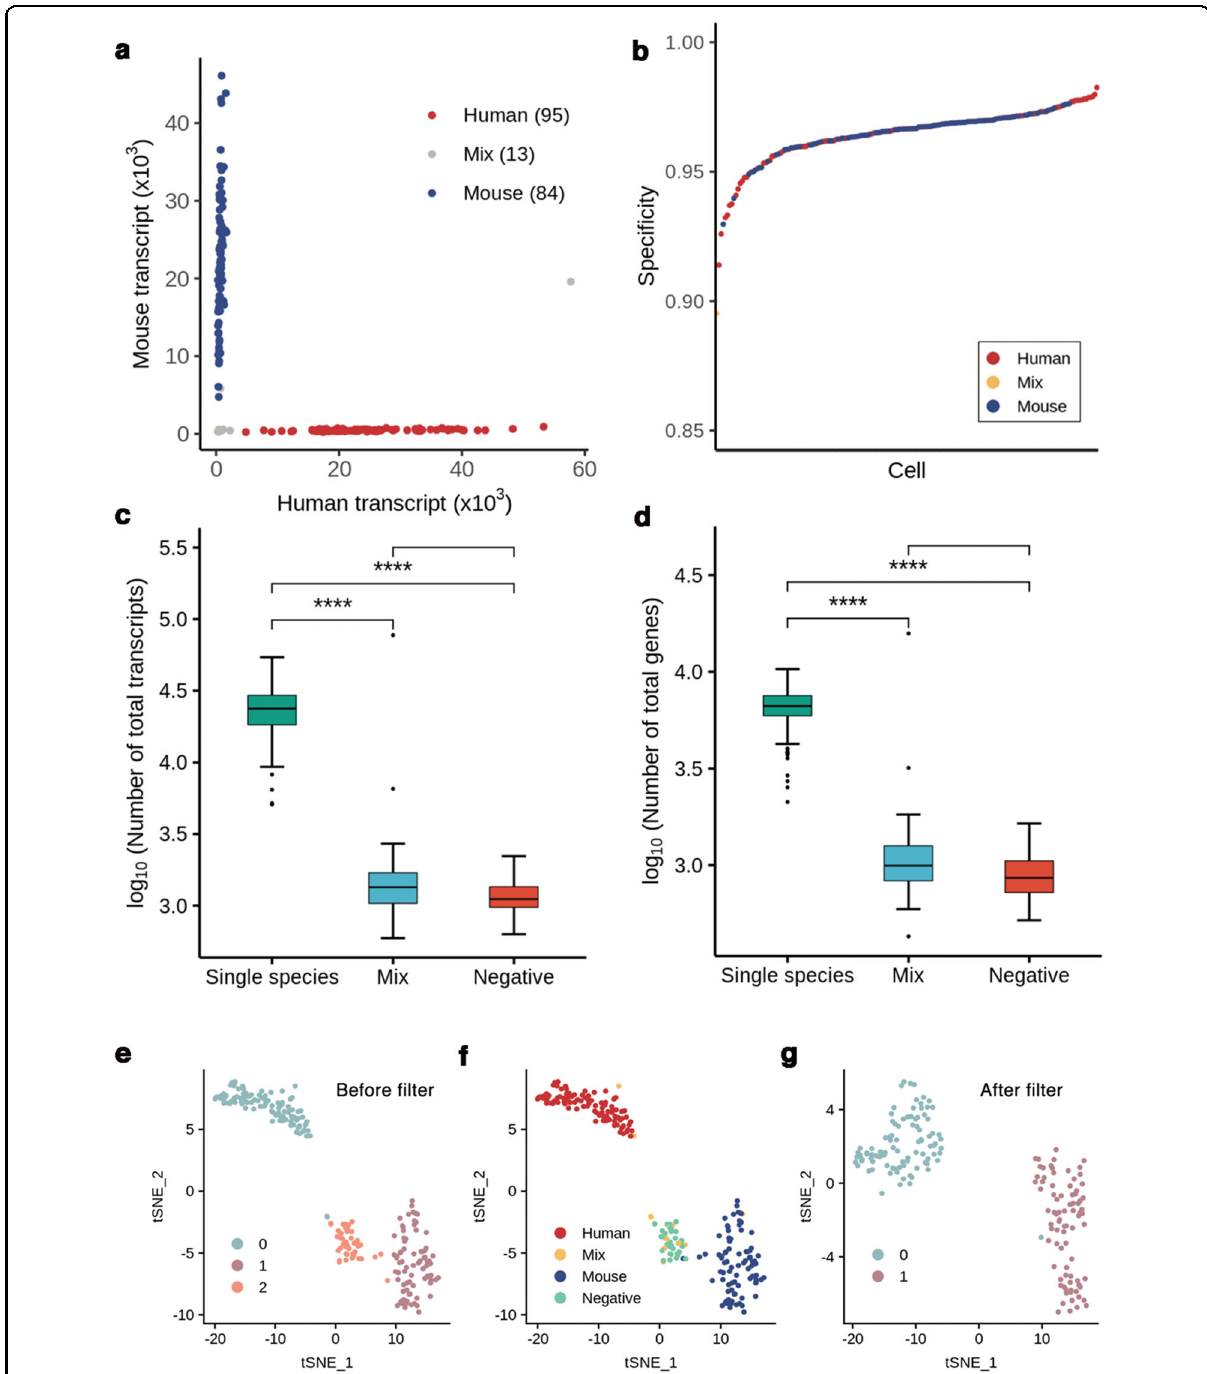
Fig. 2 Species-mixing experiment using MAPS-seq. a The species-mixing experiment used 96 HEK293T and 96 NIH/3T3 cells, and the species of each cell was identi fi ed using its speci fi city. b Plot of the speci fi city values for each cell (180 cells), determined after quality control for the transcripts. The x -axis represents each cell, and the y -axis represents speci fi city. c, d Boxplots showing the total number of transcripts ( c ) and genes ( d ) found in the species-mixing experiment. Single species: human and mouse samples, identi fi ed by the speci fi city of each cell. Unidenti fi ed: mixed species identi fi ed by the speci fi city of each cell. Negative: control samples obtained by inserting empty beads. Each y -axis value is transformed to log 10 . Signi fi cance (****) is indicated when p ≤ 0.0001. e t-SNE visualization of single cells identi fi ed by performing unsupervised clustering analysis using digital gene expression (DGE) data before sample fi ltering. Cluster names were speci fi ed by random numbers. f Overlay of the original information about the sample in e . g t-SNE visualization performed after removing the low-quality